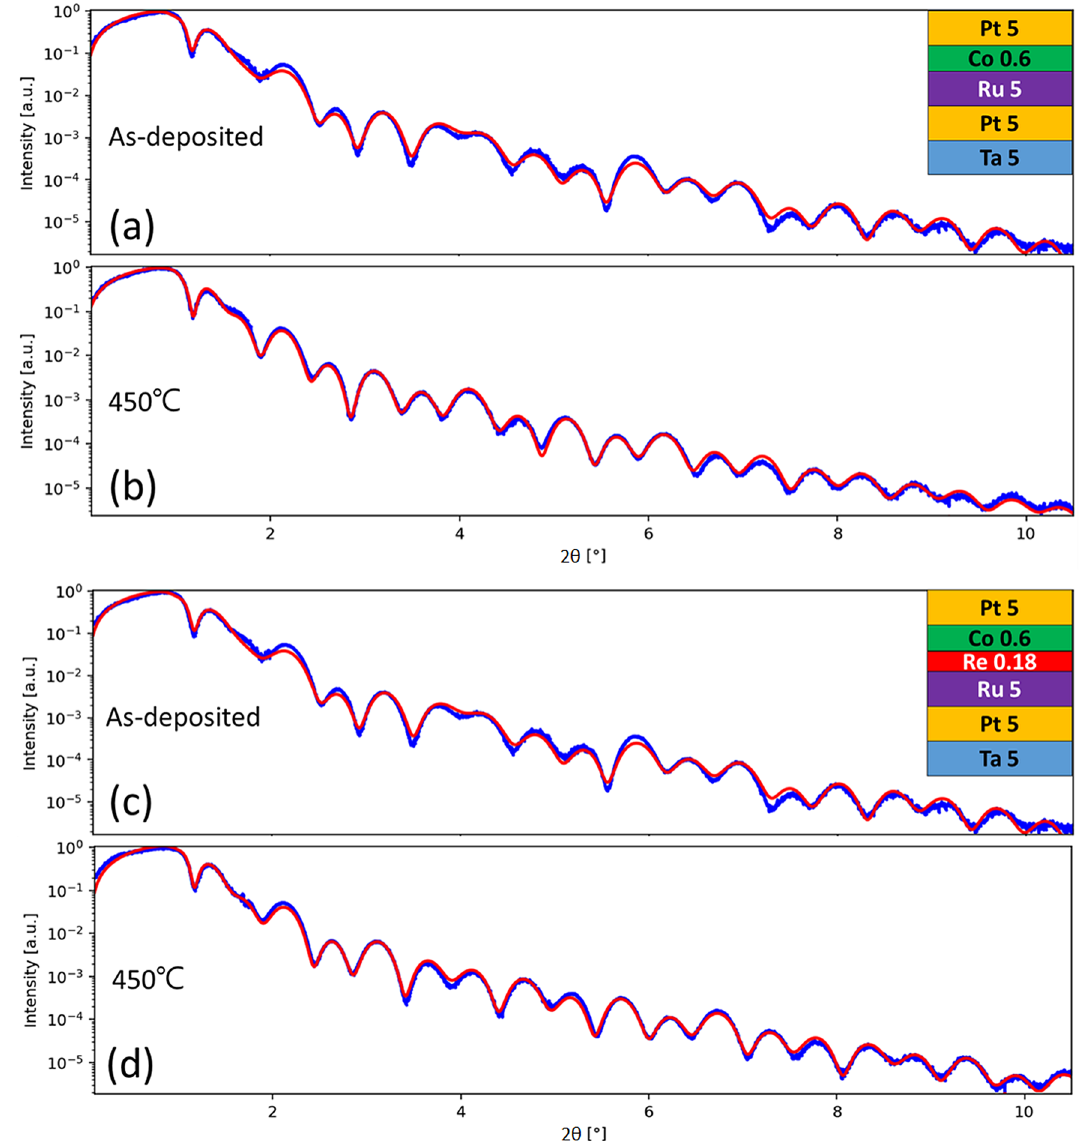
Figure 5. XRR spectra and fitting. ( a - b ) are for sample A (Ta 5/Pt 5/Ru 5/Co 0.6/Pt 5) with Ru/Co interface and ( c - d ) are for sample B (Ta 5/Pt 5/Ru 5/Re 0.18/Co 0.6/Pt 5) with Ru/Re/Co interface. ( a ) and ( c ) are for as-deposited samples, and ( b ) and ( d ) are for annealed samples at 450 °C for 1 h. The blue curves are experimental ones and the red curves are their corresponding fitting curves. The fitted roughness at Ru/Co is 0.39 and 0.55 nm for the as-deposited and annealed samples, respectively. The fitted roughness at Re/Co is 0.37 and 0.45 nm for the as-deposited and annealed samples,